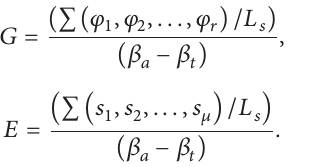
Table 3: IPDV comparison (milliseconds or ms).